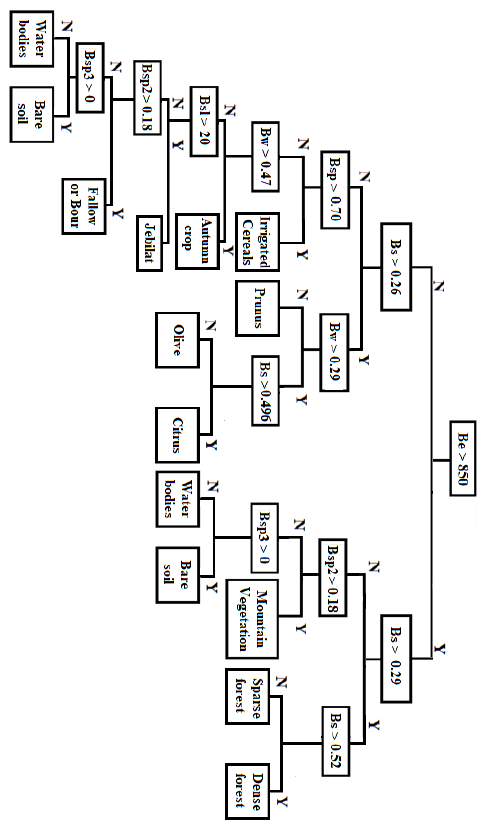
Figure 4. The hierarchical structure of Decision Tree model, along with class names and threshold values for 2018 land- cover